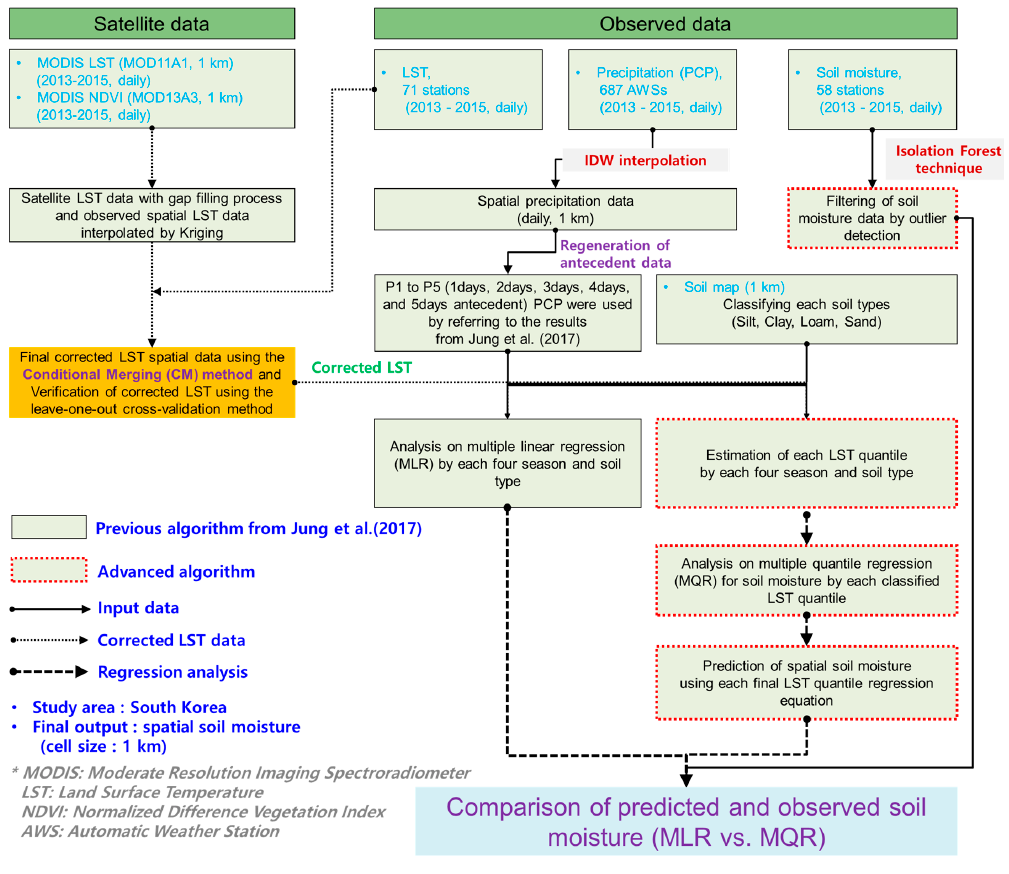
Figure 1. The study procedures.